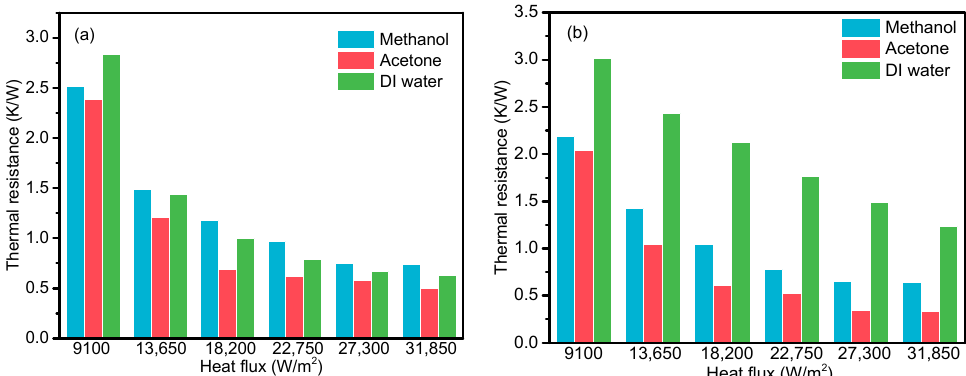
Figure 9. E ff ects of working fluids under centrifugal acceleration of: ( a ) 30 m / s 2 ; and ( b ) 738 m / s 2 Figure 9. Effects of working fluids under centrifugal acceleration of: ( a ) 30 m/s 2 ; and ( b ) 738 m/s 2.